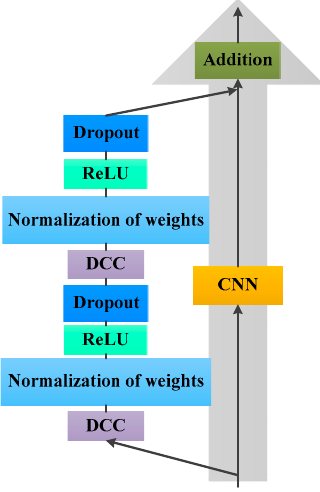
Figure 2. TCN residual block structure.